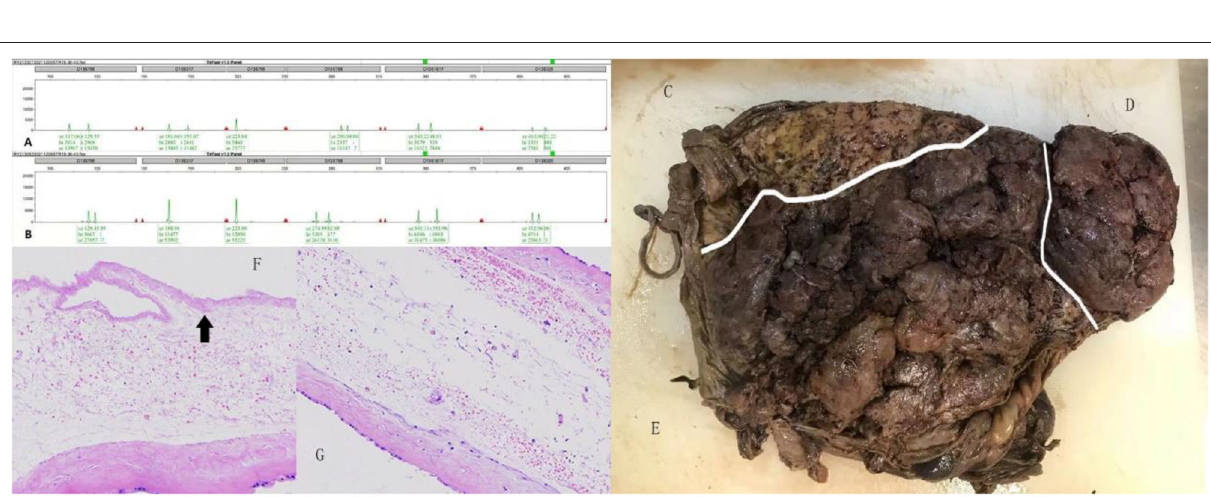
FIGURE 3 | (A,B) Indicate the genotypes of the female recipient twin and the male donor twin at different loci, respectively. Because both alleles were different, the twins were accepted as DZ. Gross placental specimen appearing of the reduced male fetus (C) , the male donor twin (D) and the female recipient twin (E) , separated by white line respectively. Histological examination of intertwin membrane between the reduced male fetus and the female recipient twin (F) , the female recipient twin and the male donor twin (G) , reveals MC component. The black arrow showing cytolysis of amniotic epithelial cells of the reduced male fetus.